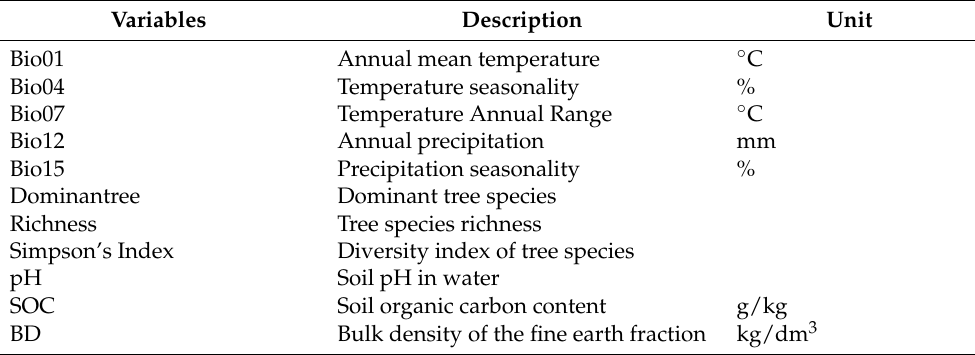
Table 2. Bioclimatic variables used for modelling the diversity and distribution of macrofungi in this